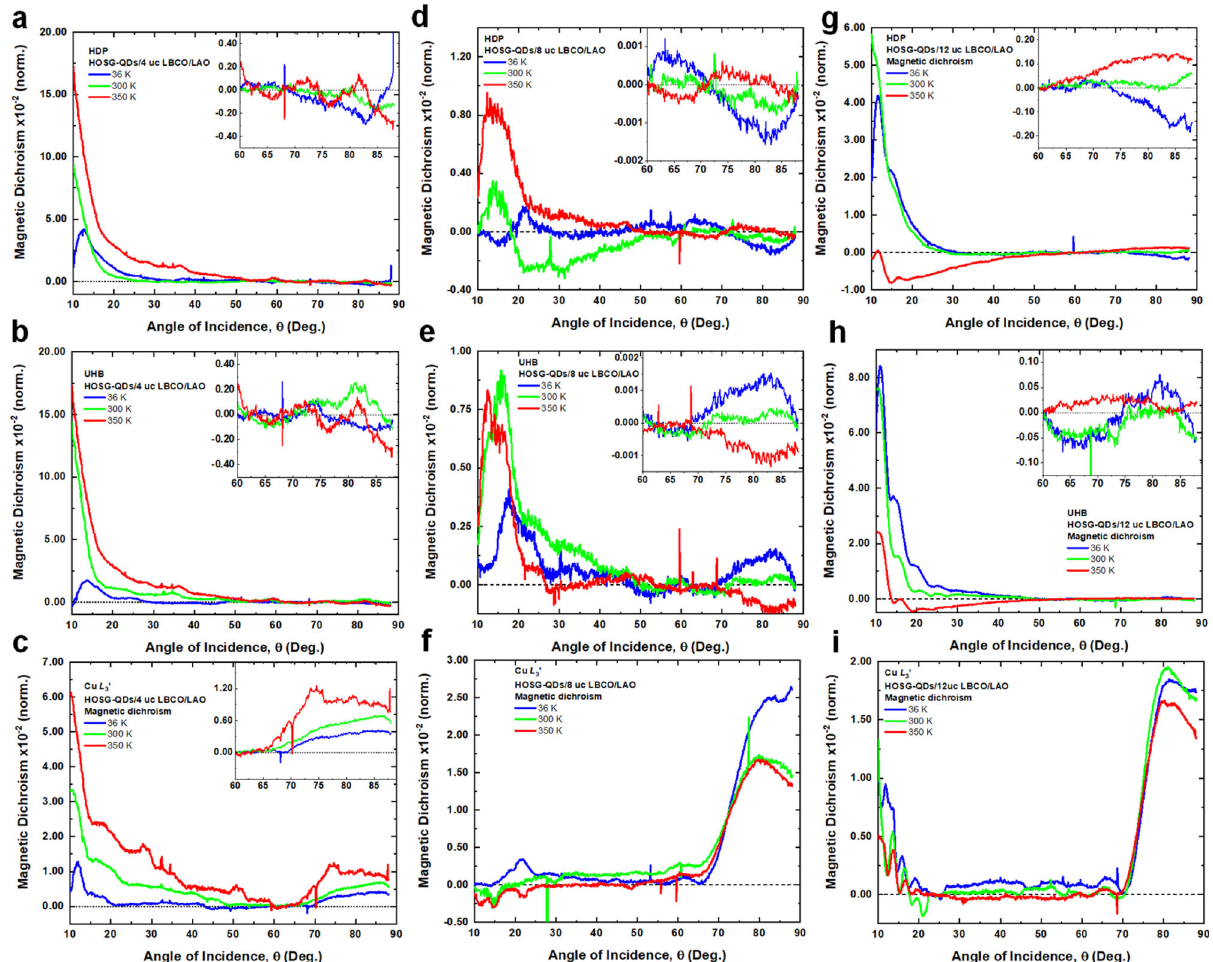
Fig. 4 Temperature-dependent RSXMS. RSXMS measurements at T = 36 K, 300 K and 350 K revealing the magnetic dichroism: for HOSG-QDs/4uc LBCO/LAO at a HDP, b UHB, and c Cu L 3 ’ ; for HOSG-QDs/8uc LBCO/LAO at d HDP, e UHB, and f Cu L 3 ’ ; and for HOSG-QDs/12uc LBCO/LAO at g HDP, h UHB, and i Cu L 3 ’ . Insets show the magni fi ed data at higher incident